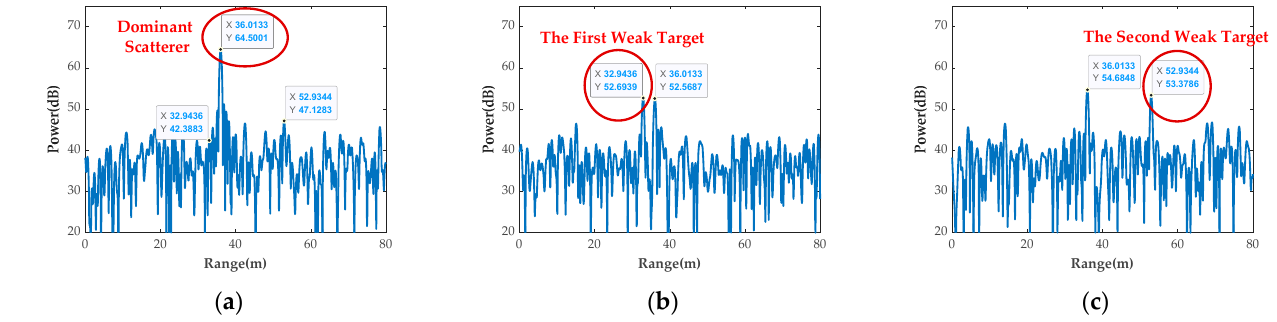
Figure 15. Multi-target CoRS results via the proposed method. ( a ) Results of the dominant scatterer.